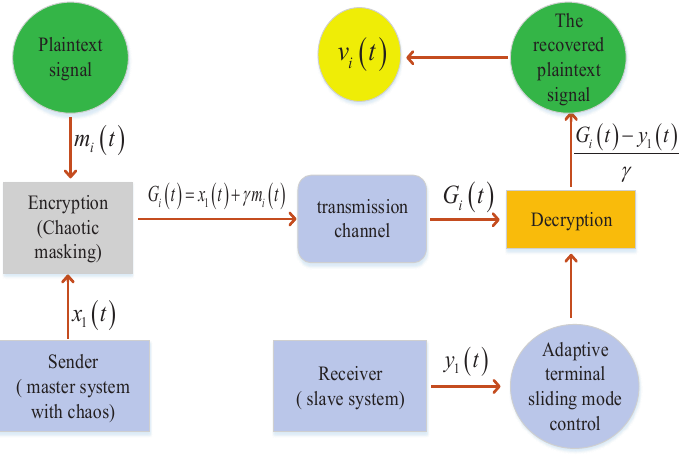
Figure 12. Secure communication scheme.